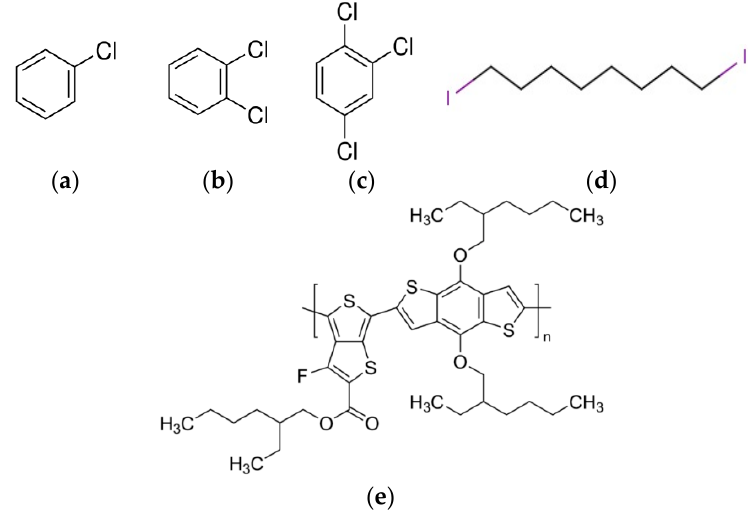
Table 1. Boiling point of the used solvents and 1,8-diiodooctane.